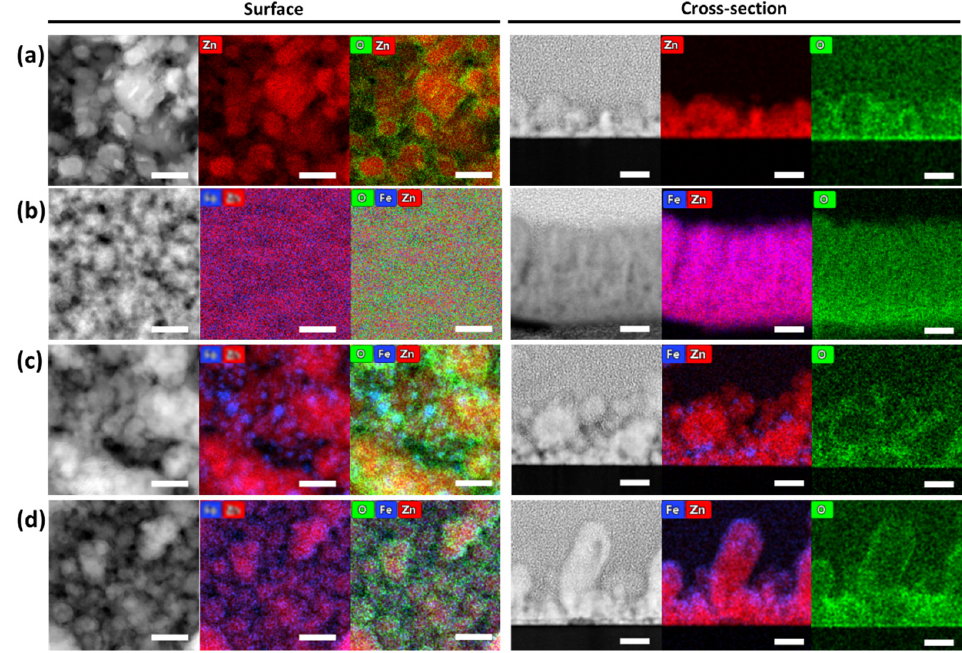
Figure 3. STEM-EDS images of the coatings: ( a ) pure Zn; ( b ) Zn-Fe alloy; ( c ) Zn NLs + Fe NPs; and ( d ) Zn-Fe NLs, viewed from the top (left) and cross-section (right). The scale bar corresponds to 40 nm. The red, blue, and green colors in the figure correspond to Zn, Fe, and O signals, respectively.